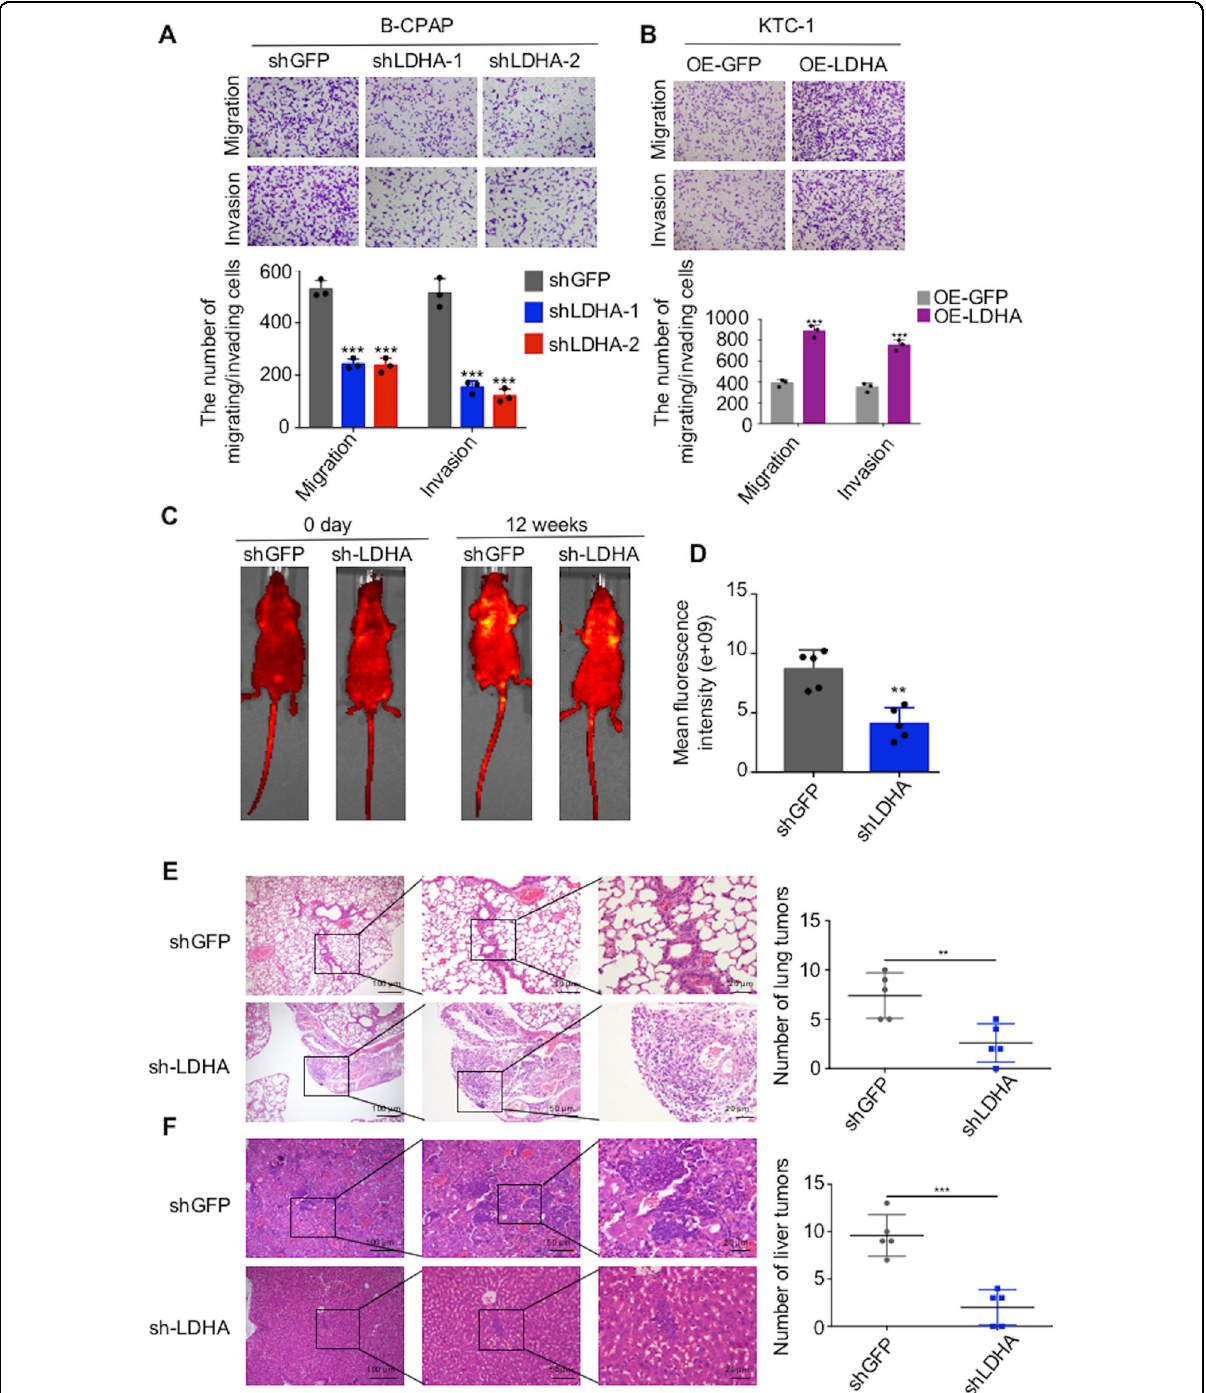
Fig. 3 LDHA promotes the migration and invasion of PTC cells in vitro and in vivo. A B-CPAP cells were transfected with two different LDHA knockdown plasmids. Representative images of migration/invasion are shown. B Representative images of migrating/invading KTC-1 cells expressing LDHA. C In vivo bioluminescence images of B-CPAP cells transfected with the LDHA knockdown plasmid. D The mean fl uorescence intensity of the LDHA knockdown group was signi fi cantly lower than that of the control group. E Representative images of lung metastatic foci. The number of lung metastatic foci was signi fi cantly lower in LDHA knockdown group than in control group. F Representative images of liver metastatic foci. The number of liver metastatic foci was signi fi cantly lower in LDHA knockdown group than in control group. The data are presented as the mean ± SD. All * p < 0.05, ** p < 0.01, *** p <